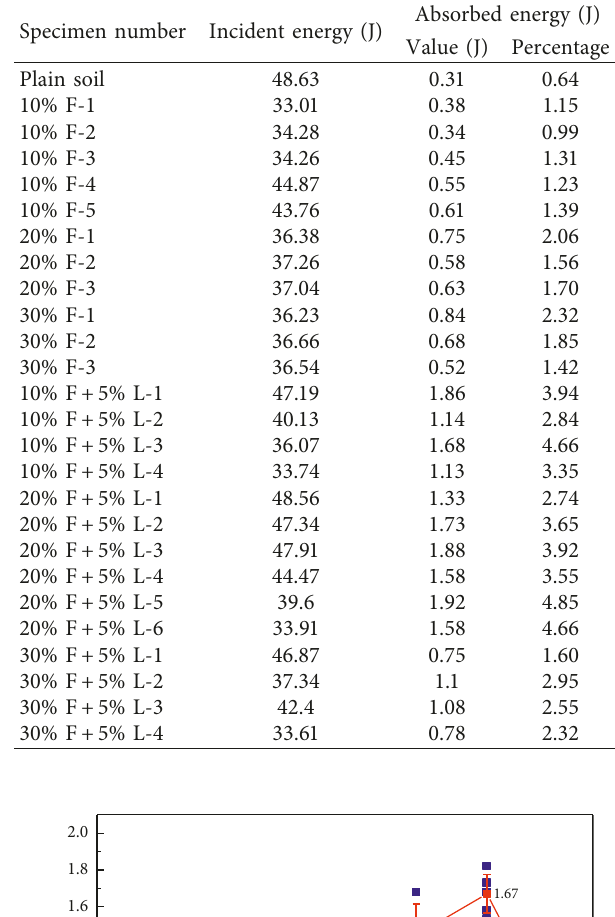
Table 2: Test results of the energy distribution of soil under dif- ferent mix proportions.